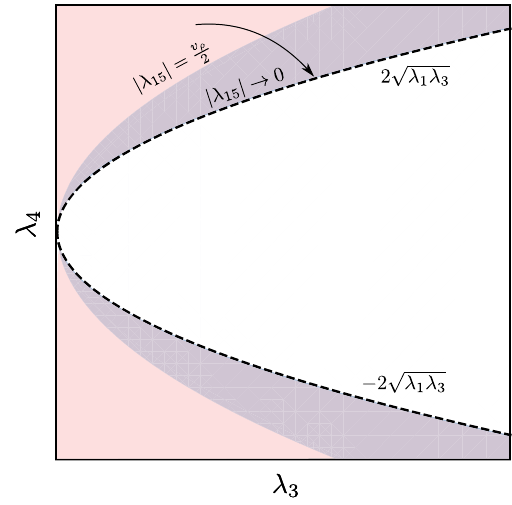
Fig. 4 The excluded region for λ 4 coming from Hessian matrix crite- rion increases when | λ 15 | decreases, and it also approaches to excluded region given by copositiviy. Similar conclusions can be reached for λ 5 and λ 6